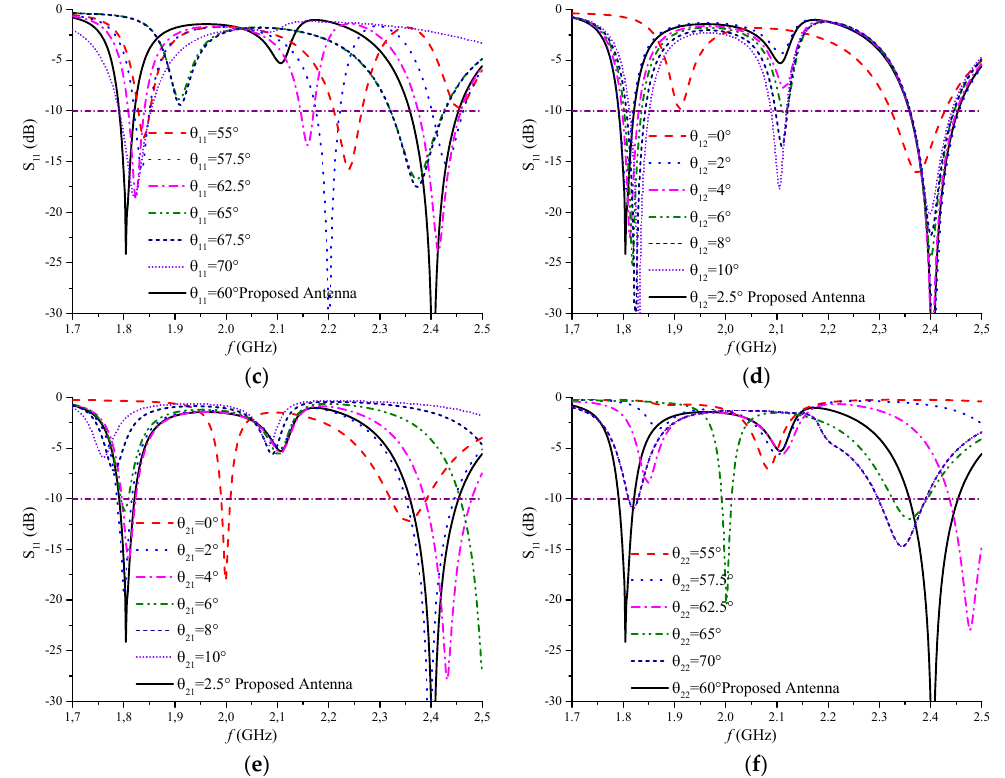
Figure 7. Length and position effects of arc-shaped slots on S 11 : ( a ) φ 1 angular start of the first arc; ( b ) φ 2 angular start of the second arc; ( c ) θ 11 angular length of the first arc; ( d ) θ 12 angular spacing between ground plane and first arc; ( e ) θ 21 angular spacing between ground plane and second arc; and ( f ) θ 22 angular length of the second arc.